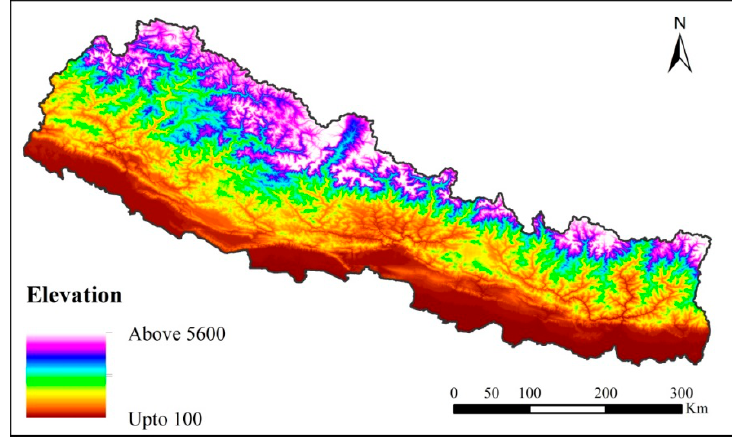
Figure 1. Map of Nepal showing 100 m elevational gradients.